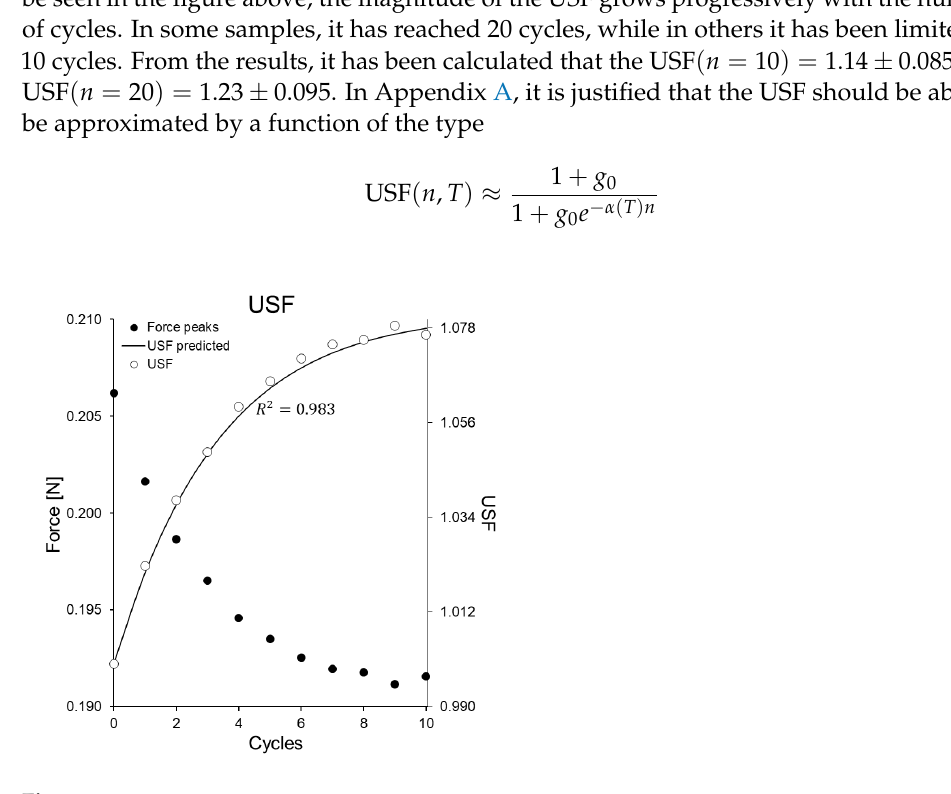
Figure 6. Force peaks in stage (2) as a function of the number of cycles performed and USF computed and predicted by Equation